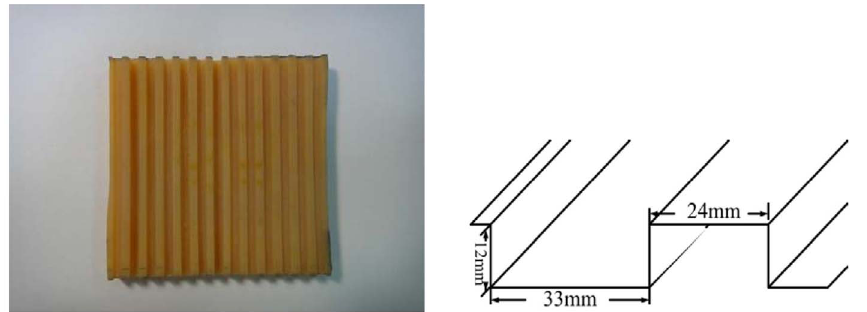
Figure 3. Tread design on the shoe sole.